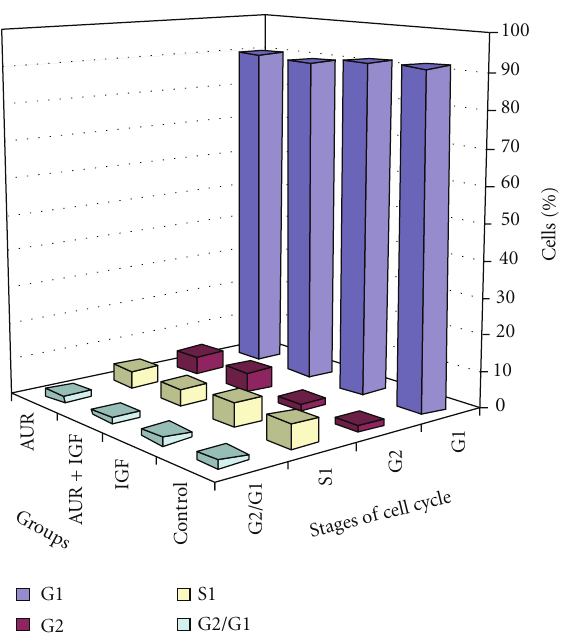
Figure 1: Cell cycle analysis of MCF-7 cells in the presence of IGF-1 at 8h. MCF-7 cells were serum starved for 24 h. At 22 h after serum starvation the cells were treated with 10 µ M auraptene in 0.01% DMSO. At 24 h serum starvation, the cells were treated with IGF-1 (10ng/mL). After 8h of IGF-1 treatment, the cells were harvested and processed for cell cycle analysis by flow